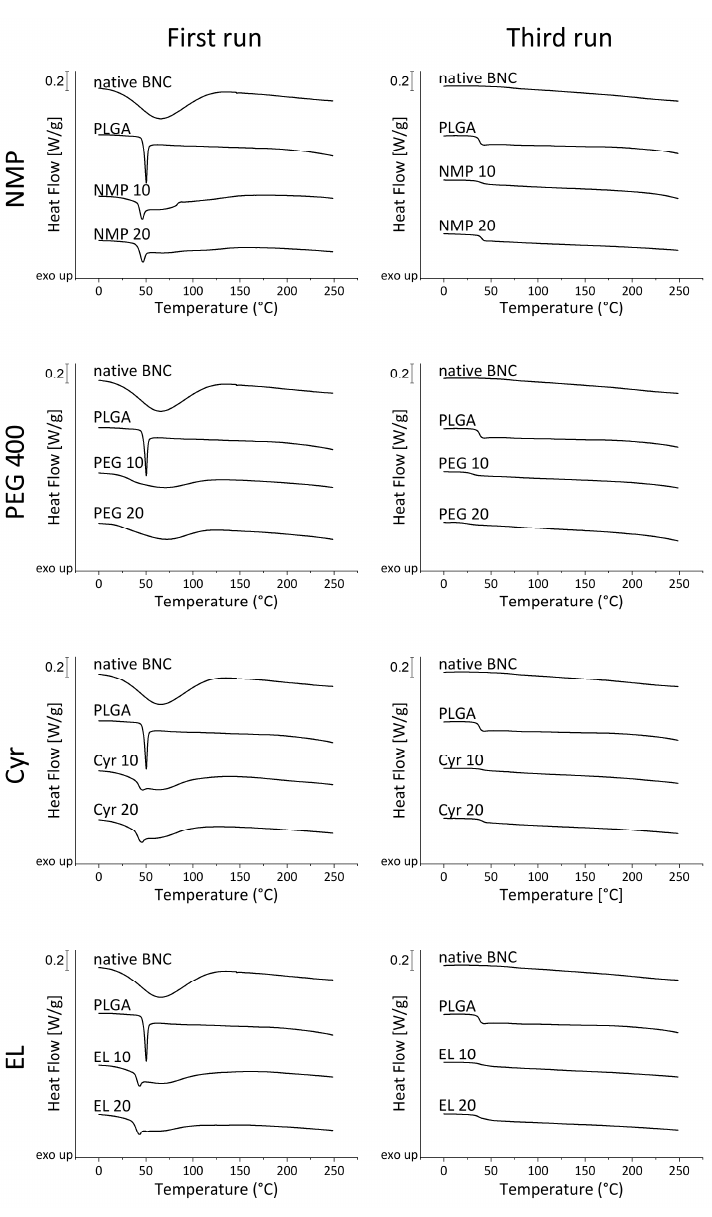
Figure 4. Differential scanning calorimetry of PLGA loaded fleeces compared to native BNC and bulk PLGA. Three heating-cooling cycles between 0 and 250 °C at 10 °C min − 1 were applied; heat flow curves of the first and third heating cycles are depicted.